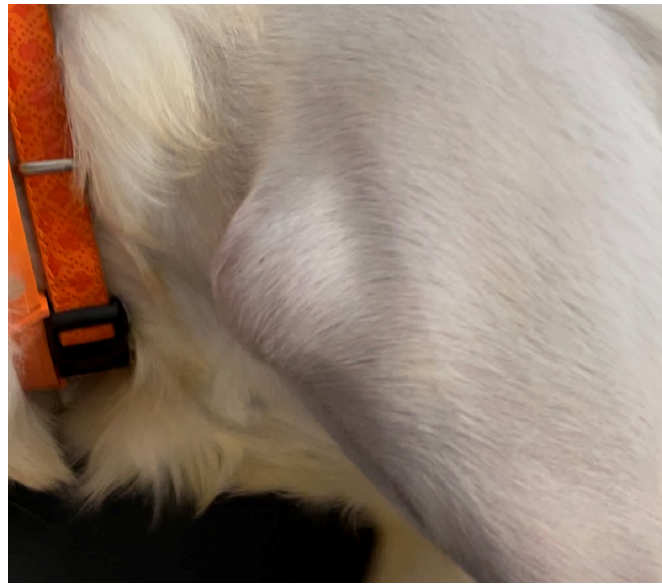
Figure 3. Seroma formation on the surgical site 20 days after surgery.